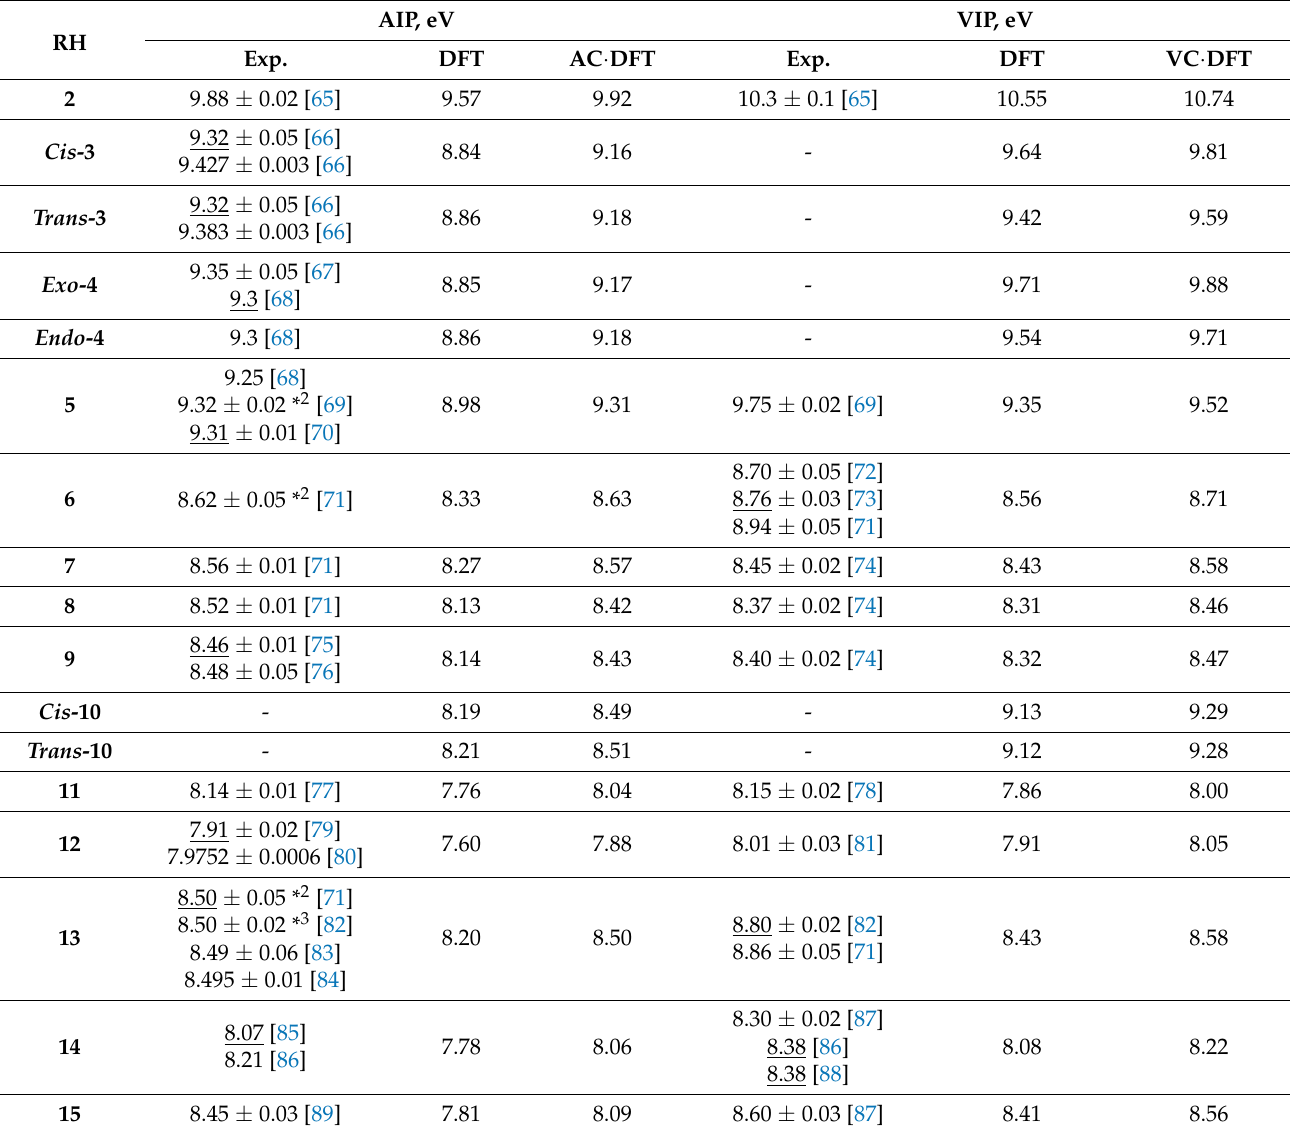
Table 3. Adiabatic ionization potential (AIP) and vertical ionization potential (VIP) of RH 2 - 15 * 1 . AIP, eV VIP, RH